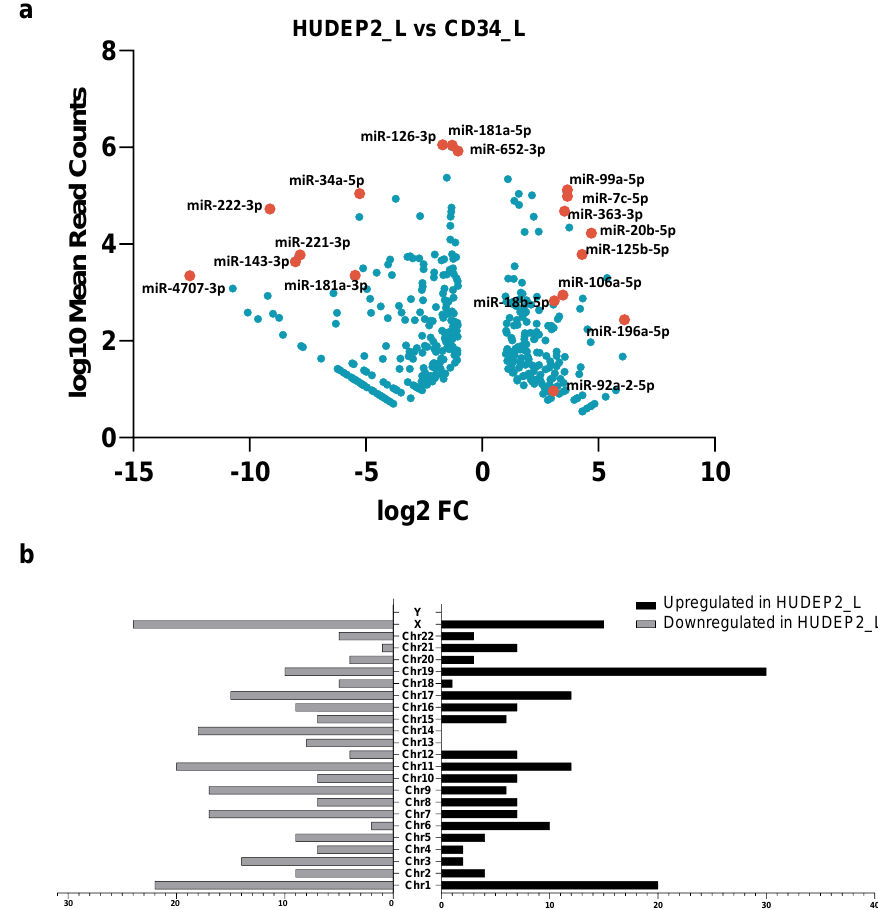
Figure 5. Differential expression analysis in HUDEP2_L vs. CD34_L for known miRNAs. DEGseq highlights differences between primary cells and a prevalent cell model. ( a ) Differentially expressed (DE) known miRNAs in HUDEP2_L vs. CD34_L. Fold changes were plotted as the log 2 FC of miRNA expression in samples against the log 10 mean normalized miRNA counts calculated by differential expression analysis to aid legibility, only a selection of miRNAs of interest and DE miRNAs with high fold change or high levels of expression are labeled (see Table S8 for a full list). ( b ) The number of HUDEP2_L vs. CD34_L DE known miRNAs located in different